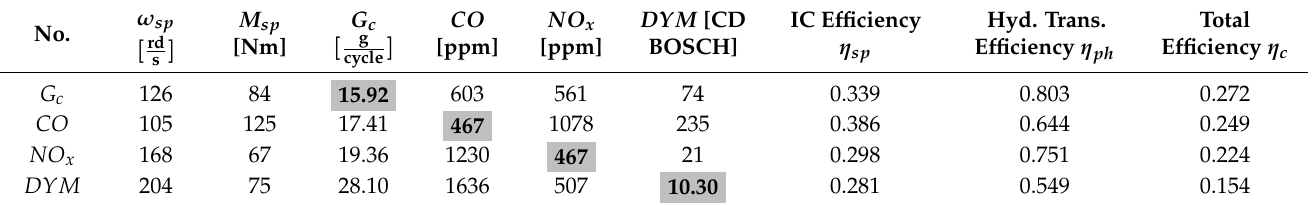
Table 4. Optimal combustion engine duty points for load I and accumulator capacity V a = 0.01 [m 3 ].